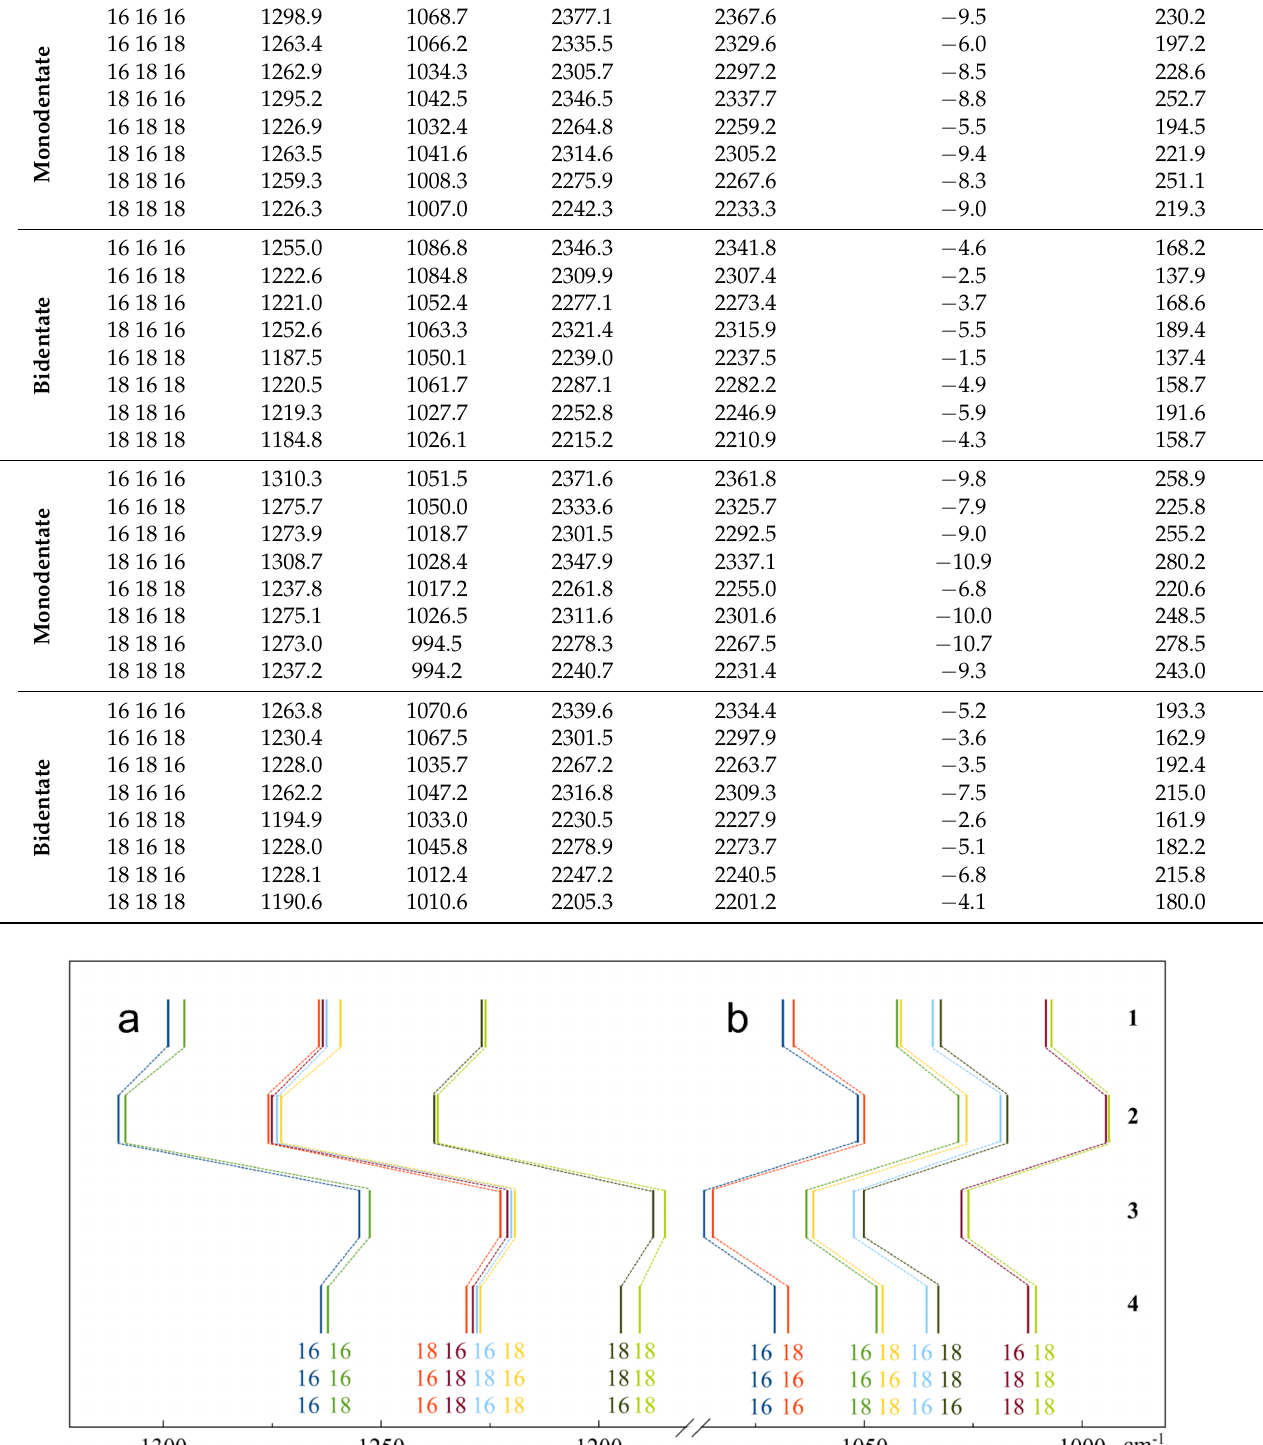
Figure 7. Positions of the bands of ν 1 ( a ) and ν 3 ( b ) vibrations of ozone isotopomers forming complexes with the Ti 20 O 40 cluster. Monodentate with 4- ( 1 ) and 5-coordinated ( 2 ) Ti 4+ ions, and bidentate complexes with the same sites of the latter cluster ( 3 , 4